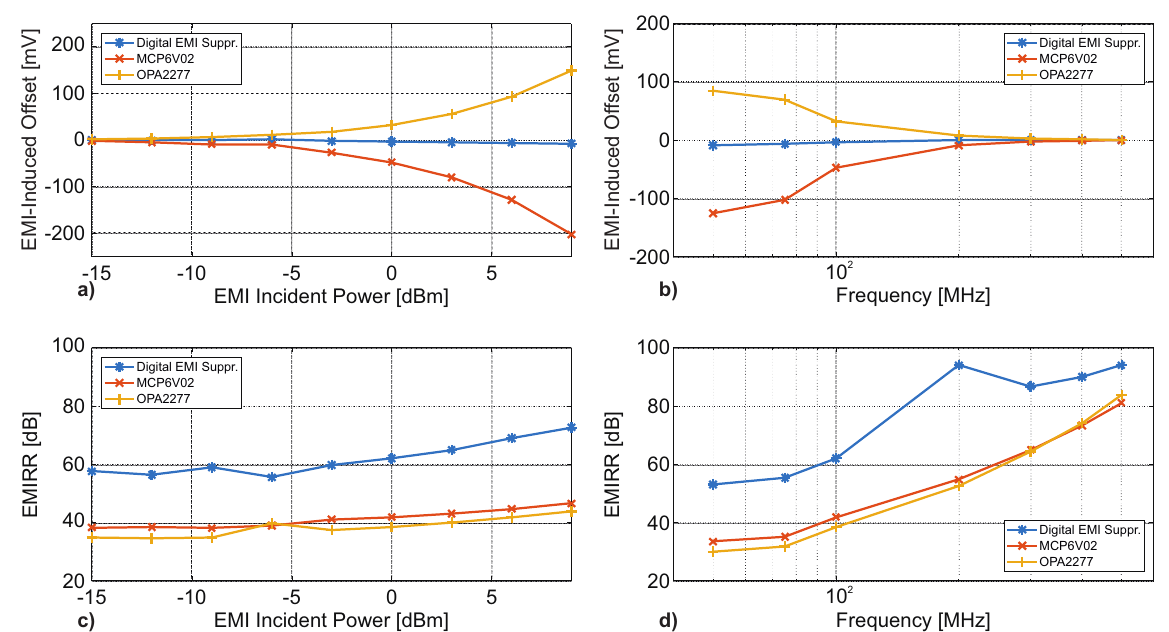
Figure 7. EMI-Induced Input Offset Voltage and EMI Rejection Ratio (EMIRR) for the proposed AFE and for the OPA2277 and the MCP6V02 opamps under continuous wave (CW) EMI excitation: ( a ) EMI-induced offset vs. CW EMI amplitude for a constant EMI frequency of 100MHz, ( b ) EMI-induced offset vs. CW EMI frequency, for a constant EMI amplitude of 0dBm, ( c ) EMIRR vs. CW EMI amplitude for a constant EMI frequency of 100MHz, ( d ) EMIRR vs. CW EMI frequency, for a constant EMI amplitude of 0